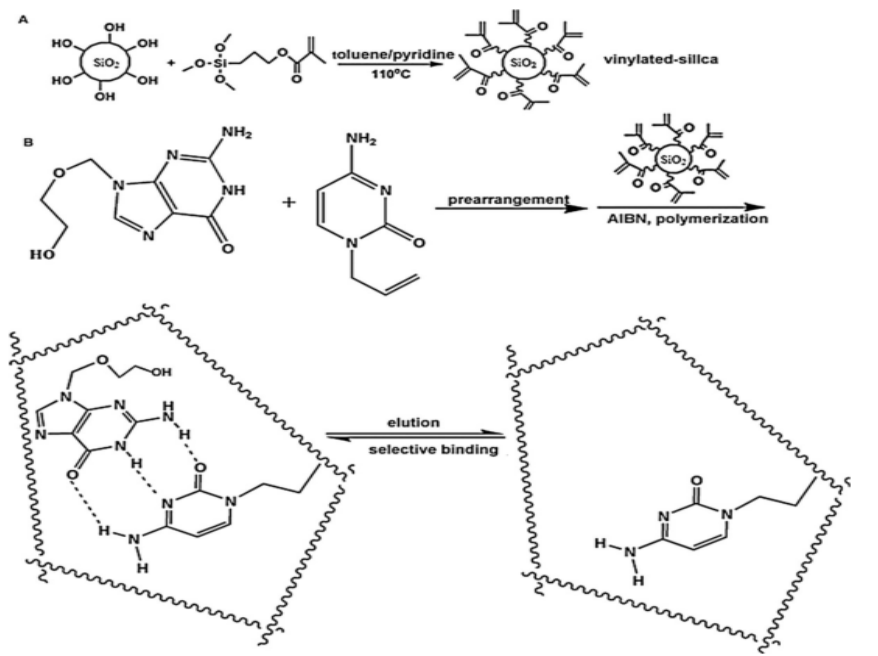
Figure 6. Preparation of MIMs, ( A ) synthesis of vinylated silica microspheres, ( B ) immobilization of MIPs on vinylated silica microspheres (reproduced with permission [97], copyright 2013, Elsevier B.V.).